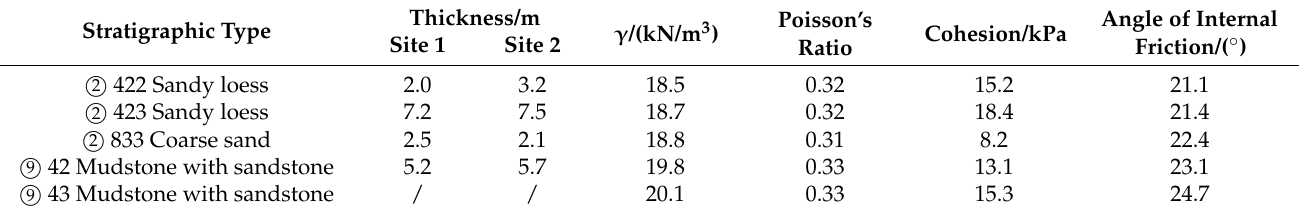
Table 1. The physical and mechanical parameters of each